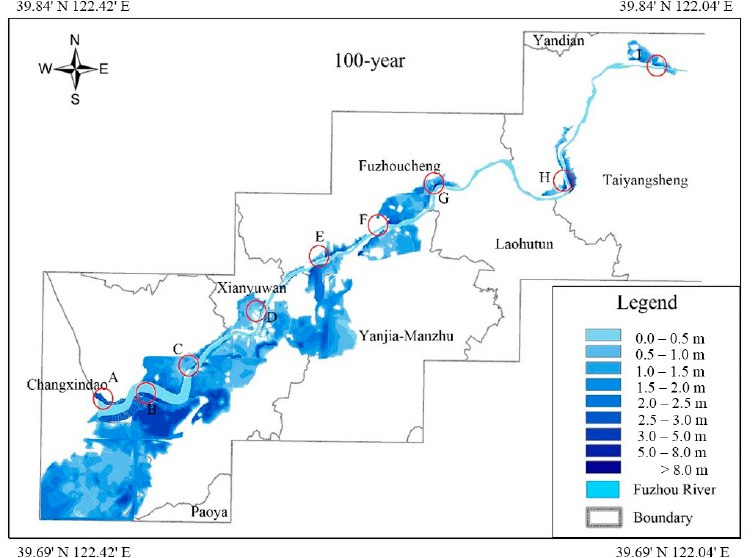
Figure 12. Flood arrival time and submerged area of 100-year return period scenario.